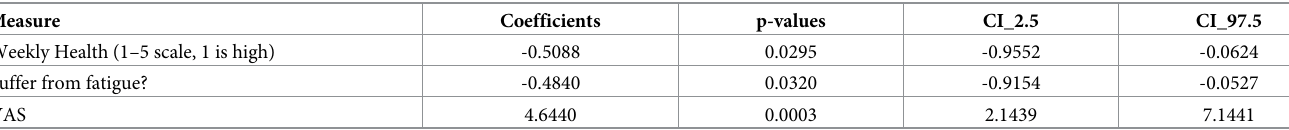
Table 2. Significant relationships between QOL measures on infusion day and day 7.